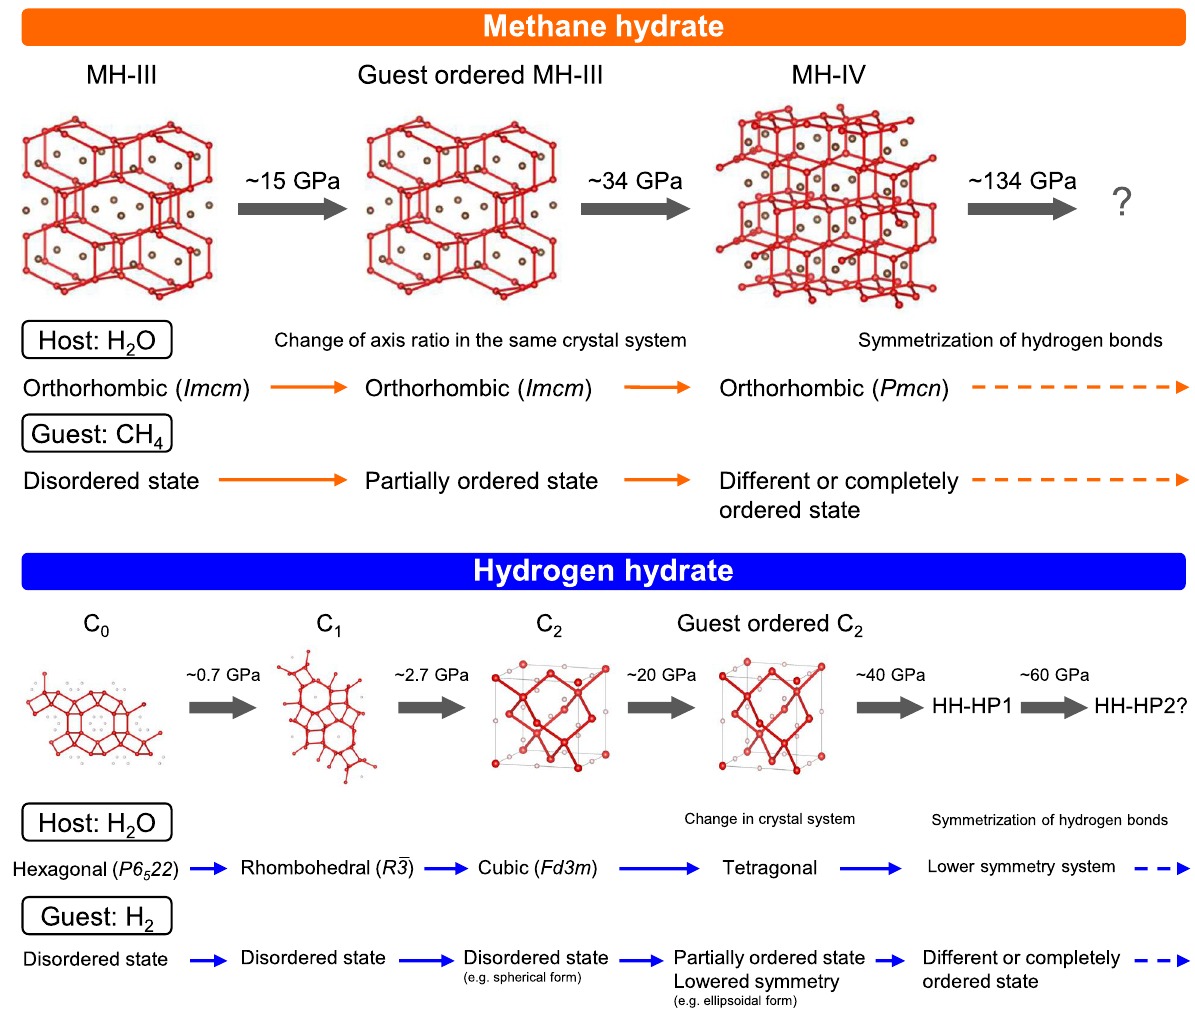
Fig. 4 An overview of the structural evolution of (top) MH and (bottom) HH after transition to the filled-ice structure, except for HH-C0. With increasing pressure, the guests undergo stepwise orientational ordering accompanied by structural changes. Hydrogen-bond symmetrization of the host was predicted to occurs at even higher pressures (further changing the structure), although this has not yet been fully verified